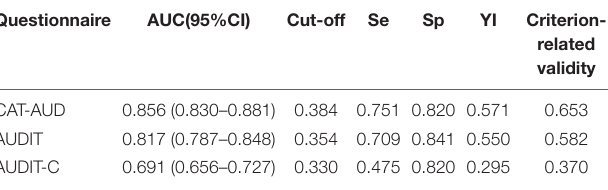
TABLE 5 | The predictive utility (sensitivity and specificity) of the CAT-AUD, AUDIT, and AUDIT-C and the criterion-related